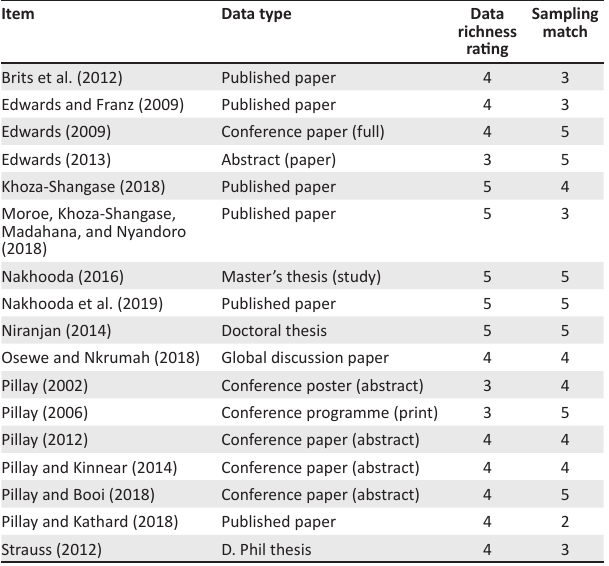
TABLE 4: Item classification by type, data richness and sampling match.